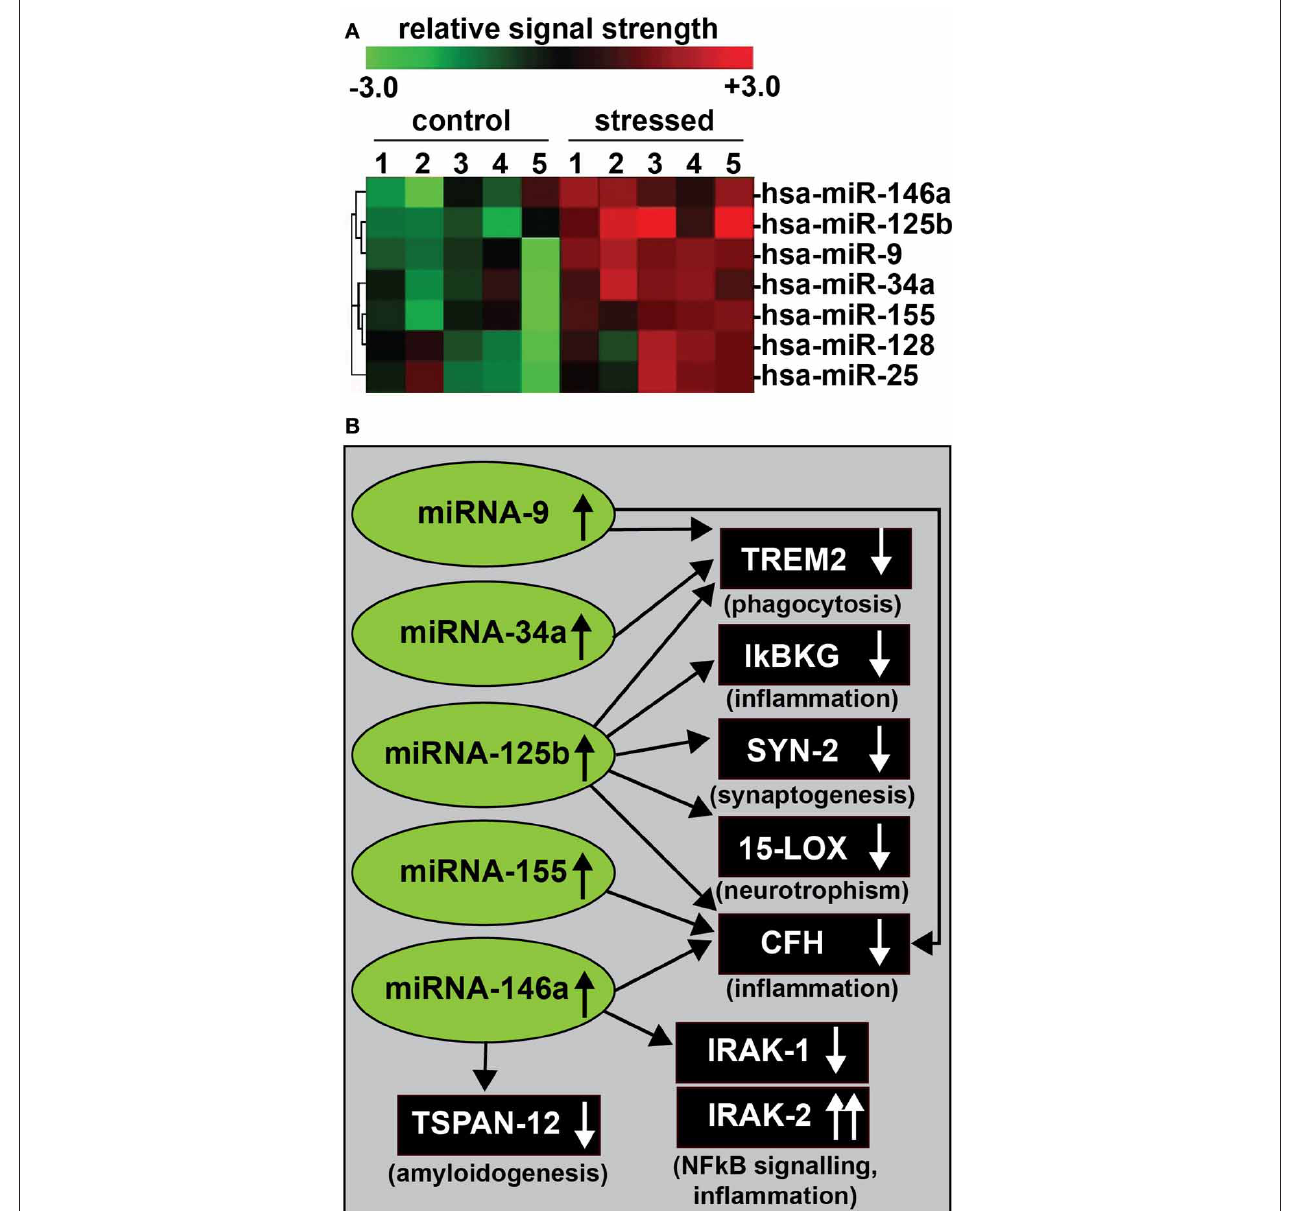
FIGURE 1 | (A) In recent experiments human primary neuronal-glial (HNG) cells were treated with an AD-relevant, NF- κ B-inducing cocktail of amyloid beta 42 (A β 42) and interleukin-1beta (IL-1 β ), and inducible miRNAs were analyzed using miRNA arrays (Lukiw, 2012a). Confirmation of miRNA induction and NF- κ B sensitivity was obtained (1) using LED-Northern dot blot and/or RT-PCR analysis; (2) by inhibition of this induction using specific NF- κ B inhibitors CAPE, CAY10512, and PDTC and (3) by bioinformatics analysis of functional NF- κ B binding sites in the promoters of the genes that encode these inducible miRNAs (Lukiw et al., 2008; Cui et al., 2010; Lukiw, 2012a). A small family of 5 miRNAs— miRNA-9, miRNA-34a, miRNA-125b, miRNA-146a, and miRNA-155 —appear to be up-regulated in high quality total RNA isolated from short post-mortem AD brains; note that hsa-miR-128 and miR-25 are variably up-regulated; N = 6; (B) These findings in part define a highly interactive network of NF- κ B-sensitive, up-regulated miRNAs in stressed human brain cells and AD hippocampus that can explain much of the observed neuropathologyin AD including deficits in phagocytosis